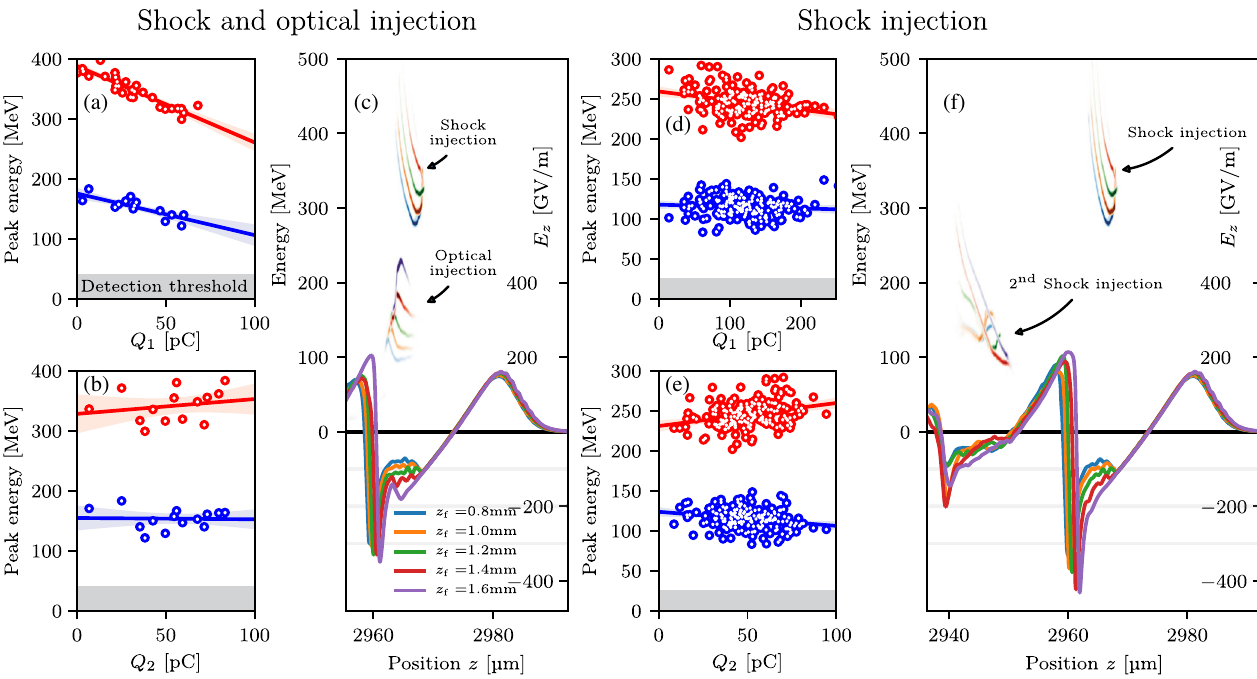
FIG. 4. Effect of beam loading on dual-energy electron beams injected into either the first or second wakefield cavity. First column: Experimental data for electron injection into the first wakefield period via shock and optical injection. The data are sorted either by the charge in the high-energy beam (denoted with charge Q 1 ) (a) or by the charge in the low-energy beam ( Q 2 ) (b). Dotted lines show linear fits, and the shaded areas indicate the corresponding confidence interval. The data show a clear correlation between the charge of the shock-injected beam Q 1 with the energy of the optically injected beam E 2 (a). (c) Results from particle-in-cell simulations showing both the phase space and the longitudinal on-axis fields. Beams of different charge are injected by changing the absolute focus position z f ¼ 0 . 8 mm. Higher charges Q relative to the density transition z 1 decrease the accelerating fields in the wakefield via beam loading, shock leading to a lower energy of the trailing optically injected electron bunch. Third column: Experimental data for electron injection into the first and second wakefield periods via shock injection. The high-energy beam seems to have no influence on the particle energies in the second wakefield period (d). In contrast to (b), the charge of the second bunch ( Q 2 ) is correlated to the energy of the first electron bunch (e). (f) Particle-in-cell simulations with the same color coding as in the aforementioned plot, showing the same behavior as in (d). The energy of the second beam is uncorrelated to the charge in the first beam, which matches the experimental